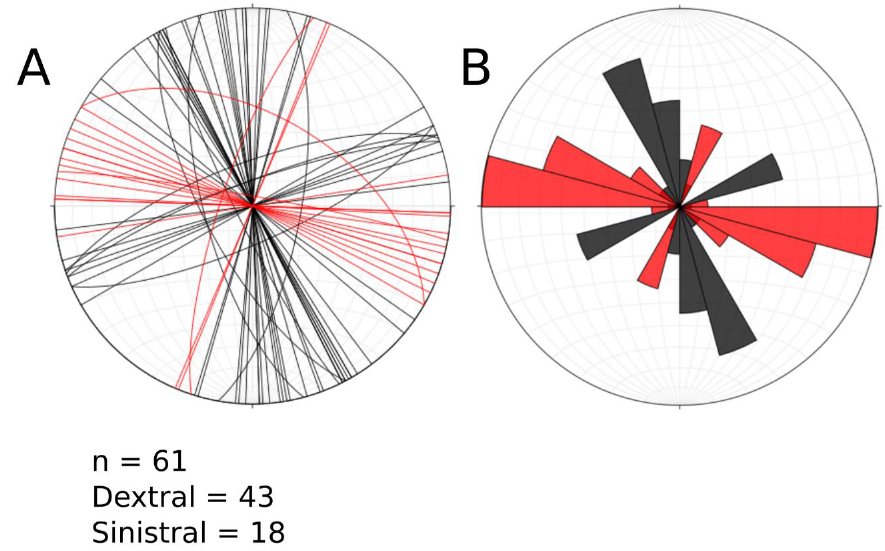
Figure 8. ( A ) Stereonet showing the orientations of fracture zones, such as those in Figure 7, categorised as either sinistral (red) or dextral (black). Most fracture zones are plotted as vertical as their dip could not be discerned from the field observations. ( B ) The data from subfigure ( A ) plotted on a rose diagram using 15 ◦ bins (total bins = 24) and divided into two dextral and two sinistral sets of structures. The data presented in this figure were plotted in the Stereonet software for OXS